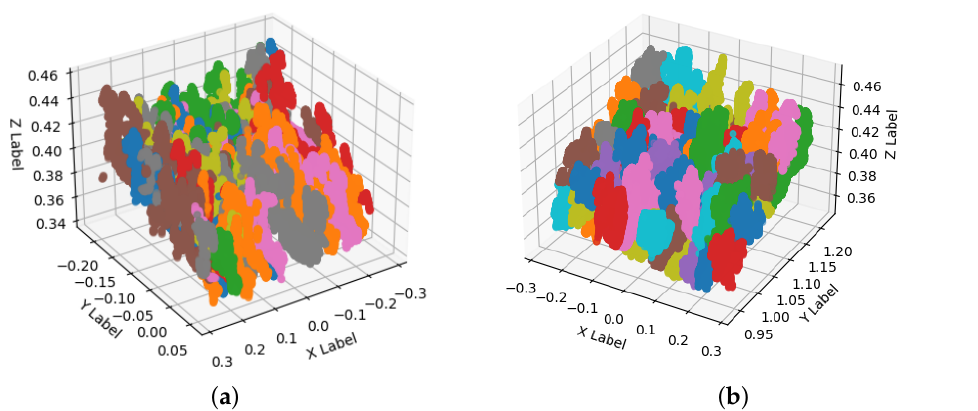
Figure 8. Seedling segmentation. ( a ) The result of KMeans segmentation. ( b ) The segmentation with Gaussian Mixture